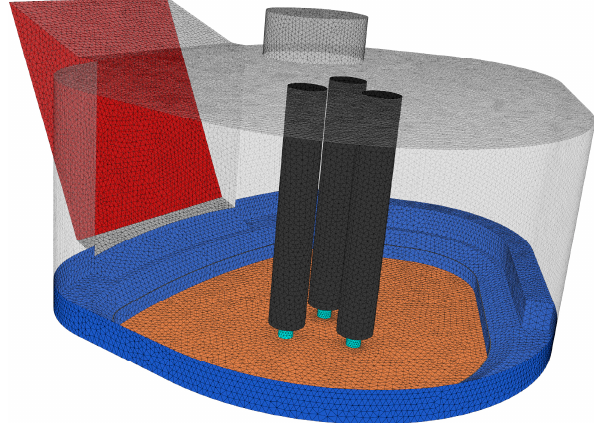
Figure 6. Discretized geometry used for view factor calculation. Table 3. Temperatures for the calculation of 𝑄(cid:4662) (cid:3045)(cid:3028)(cid:3031),(cid:3006)(cid:3002)(cid:3007) during phase 2 (geometry is shown in Fig- ure 6) Color Red Blue Cyan Orange Gray Temperature in °C Modeled 1500 4500 1650 900